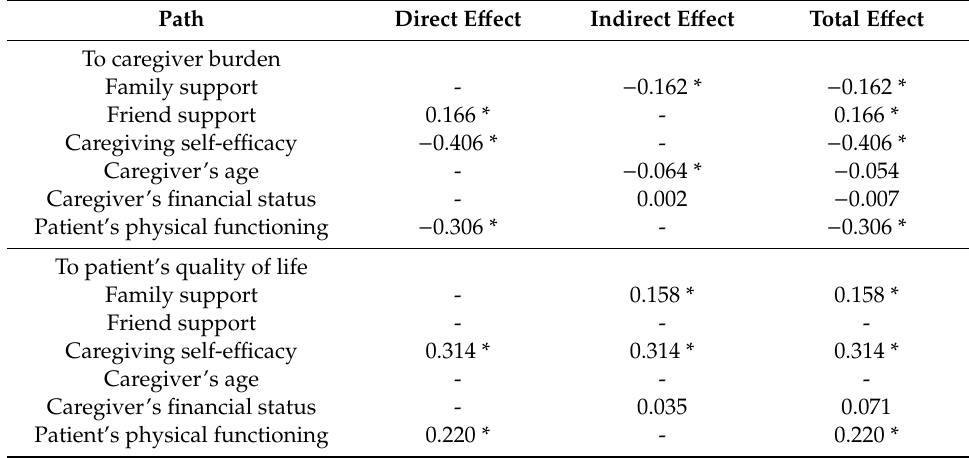
Table 3. Standardized direct, indirect and total e ff ects of variables on caregiver burden and patient’s quality of